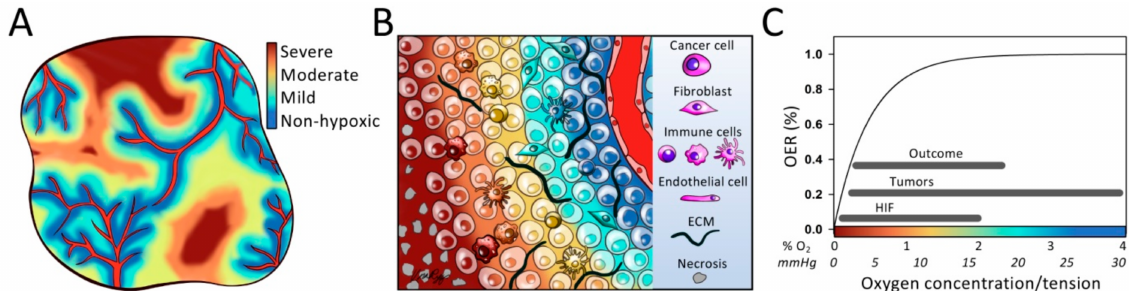
Figure 1. Distribution of hypoxia levels in tumors. ( A ) Illustration showing distribution of hypoxia levels from mild to severe in a section through a solid tumor. Non-hypoxic levels are seen close to capillaries (in red). ( B ) Close-up of a region in ( A ), showing the gradient in hypoxia levels from a capillary towards severe hypoxia. Symbols for different cell types and extracellular matrix (ECM) are indicated. ( C ) Illustration of how oxygen enhancement ratio (OER) increases with increasing oxygen concentration or tension in tumors, where OER is defined as the ratio between the dose needed to cause the same harmful effect to cells under anoxia and when oxygen is present. Data relative to maximum OER are shown and the curve is based on the study by Koch and coworkers described in [3]. The ranges indicated refer to the scale of the x -axis and are median pO 2 values reported across tumor types, median pO 2 cutoff for hypoxic fractions associated with poor radiotherapy outcome across tumor types, and median oxygen concentration reported for activation of hypoxia inducible factors (HIF). The pO 2 data are collected from [5] and the HIF data are based on [6,7]. ( A – C ) Hypoxia levels are indicated by the color code, with approximate oxygen concentrations (% O 2 ) and tensions (mmHg) provided by the x -axis in ( C